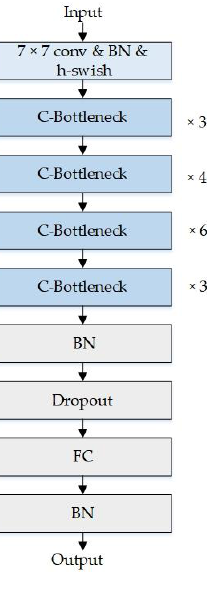
Figure 5. The backbone network of the improved ResNext50.